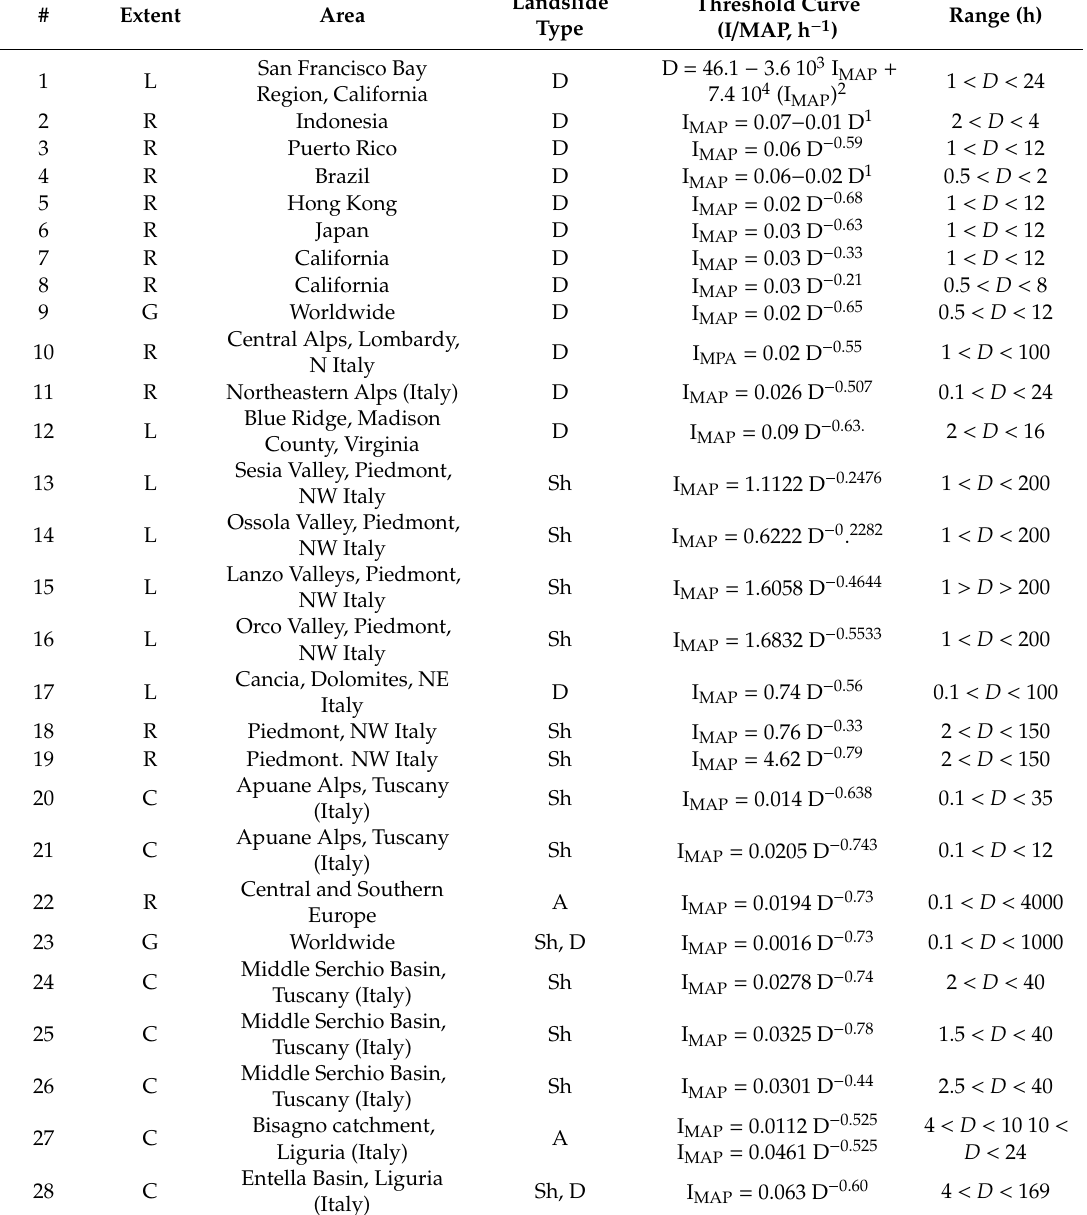
Table 3. MAP-normalized rainfall intensity IMAP (h − 1 )–rainfall duration D (h) thresholds for the initiation of shallow landslides and mud-debris flows in alpine or mountain regions in Italy